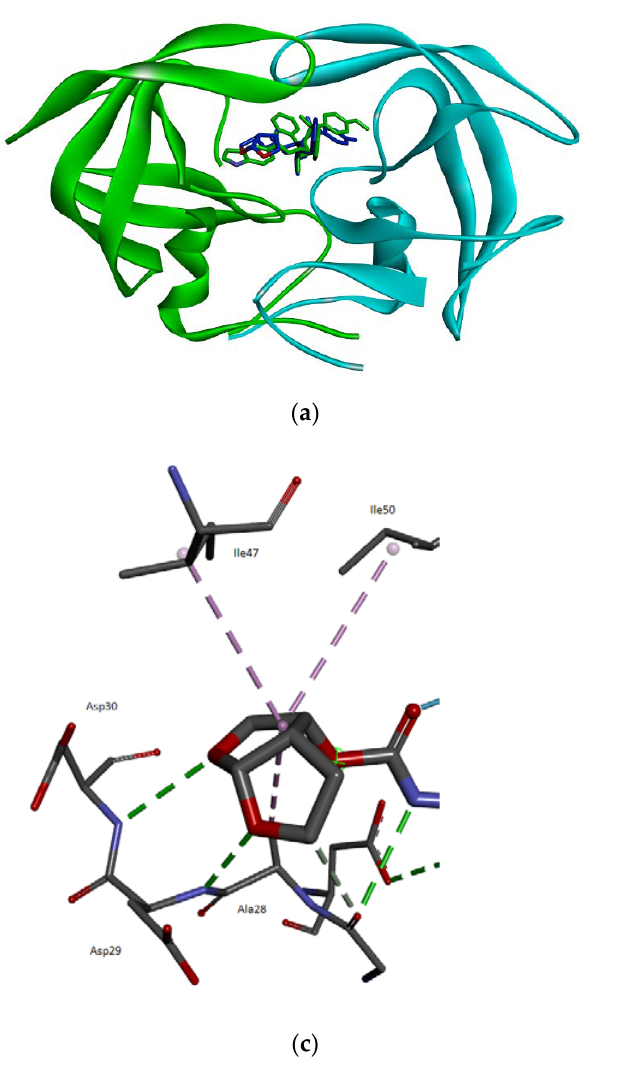
Figure 3. ( a ): Overlay of the crystallographic structure of the Hiv-pr complex with darunavir and the model structure of the complex of 9b ; ( b ): overlay of the model structures of the complexes of 7b , 8b and 9b with the protease; ( c ): interactions of the dioxabicyclo octane group of darunavir with the protein; ( d ): interactions of the indole system of 9b with the protein.